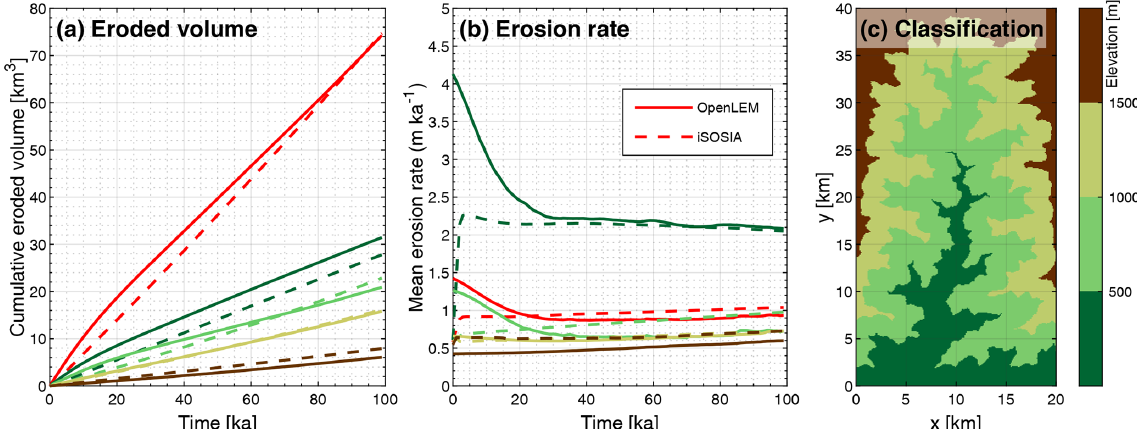
Figure 3. Differences and similarities in the erosion history as computed by iSOSIA and OpenLEM (shown as dashed and solid lines, respectively). (a) Cumulative eroded volume and (b) mean erosion rate of the entire landscape (red lines) and the rising elevation ranges as shown in (c)